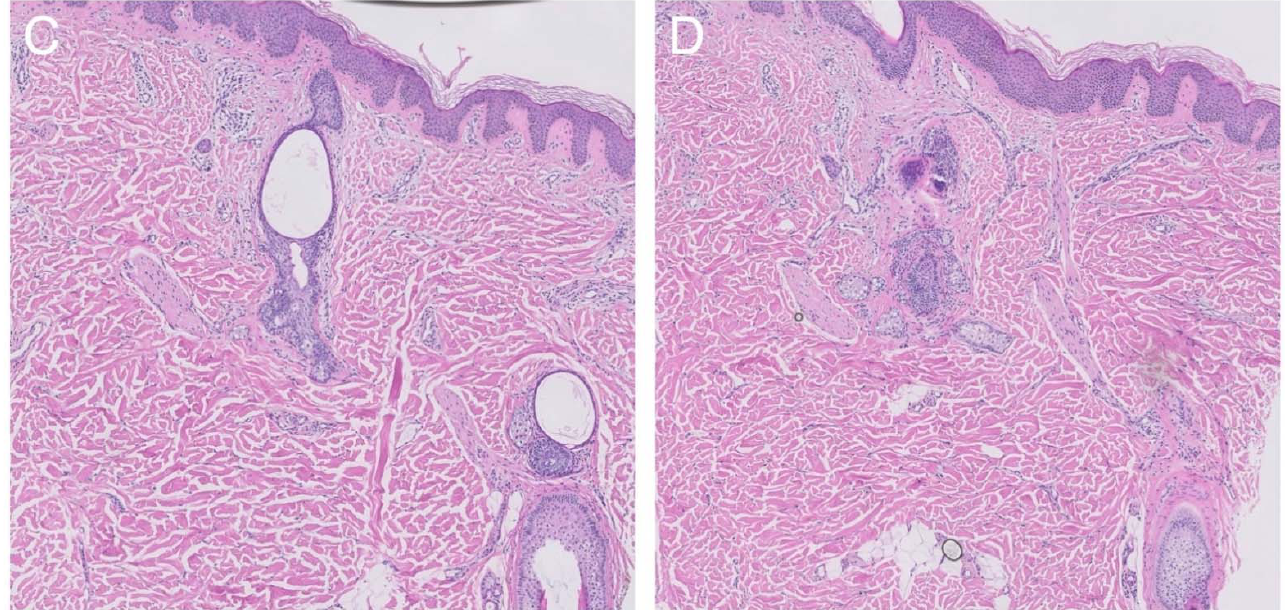
Figure 2. ( A – D ) Histopathology . ( A ) A skin biopsy from the slightly palpable Blaschkoid hyperpigmentation on the right arm in individual 1 shows features suggestive of epidermal nevus, including discrete acanthosis, hyperkeratosis and pigmentation of the basal layer (magnification ×100). ( B ) Similarly, epithelial hyperplasia and papillomatosis confirm the diagnosis of epidermal nevus on the chin of individual 2 (magnification ×400). ( C , D ) A skin biopsy taken in the focal region of alopecia in individual 1 shows the presence of fat in the dermis, tissue fibrosis and an anagen arrest of hair follicles, indicative of nevus psiloliparus (magnification ×100).